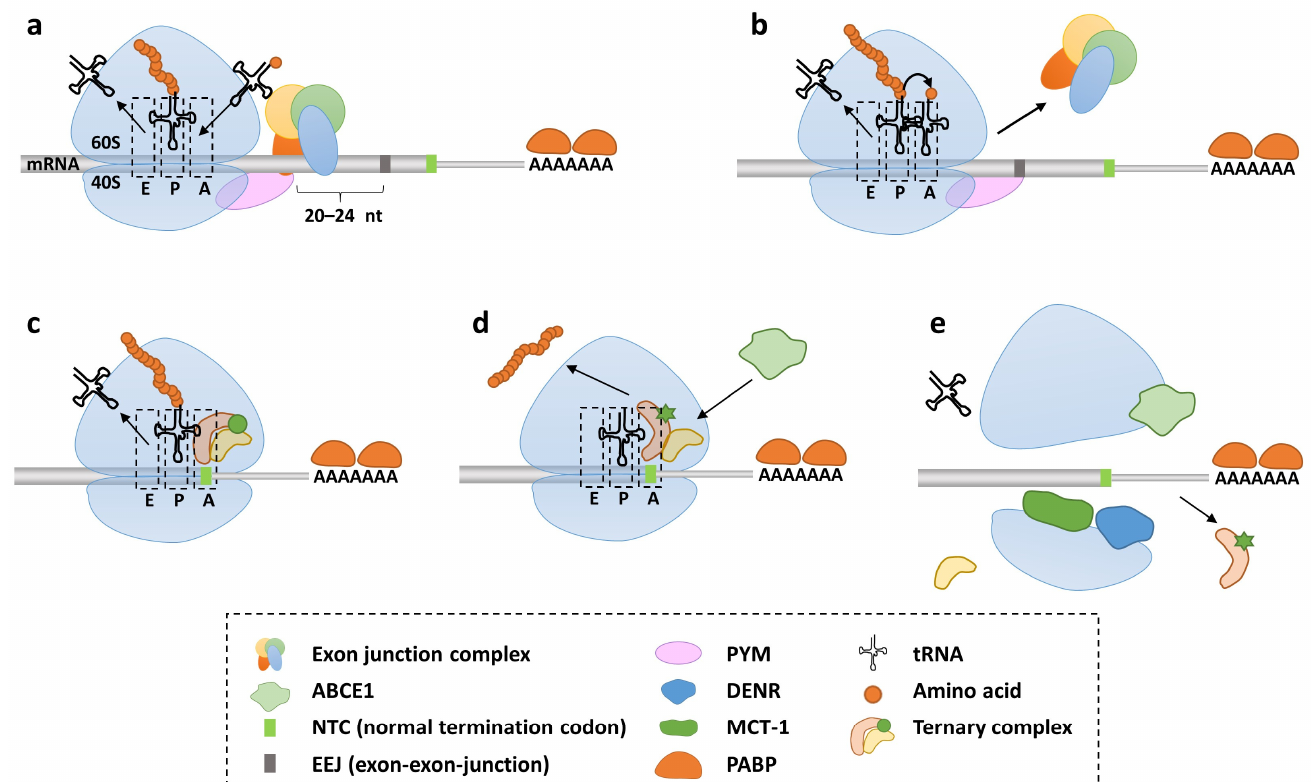
Figure 1. Translation termination at normal termination codons. ( a ) During translation, the ribosome (assembled from a 60S and a 40S subunit) transverses the capped and polyadenylated mRNA to translate it into a polypeptide. Incoming aminoacyl-tRNAs decode the mRNA and are accommodated in the A-site. The P-site hosts the peptidyl tRNA and during elongation by peptidyl transferase activity transfers the growing peptide chain onto the incoming amino acid of the A-site tRNA. During translocation, the elongated A-site tRNA moves into the P-site, while the bare P-site tRNA leaves the ribosome via the E-site. Exon junction complexes (EJC comprises eIF4AIII, Y14, MLN51 and MAGOH) decorate the mRNA approximately 20–24 nucleotides upstream of each exon–exon-junction (EEJ). PYM associates with the small ribosomal subunit and mediates interaction with EJC components. ( b ) As the ribosome moves along the mRNA during the pioneer round of translation, EJCs are removed along the mRNA and the ribosome arrives at the normal termination codon (NTC). ( c ) Upon encountering an NTC, the ternary termination complex (composed of eukaryotic release factors eRF1 and eRF3 activated by GTP) enters the A-site. ( d ) After stop codon recognition and GTP hydrolysis, the polypeptide is released from the peptidyl-tRNA located in the P-site. ( e ) Ribosome recycling post- termination is initiated by the ATP-binding cassette sub-family E member 1 (ABCE1) to dissociate the subunits. Multiple copies in T-cell lymphoma-1 (MCT-1) together with density-regulated protein (DENR) promote the dissociation of deacylated tRNA and mRNA from the 40S